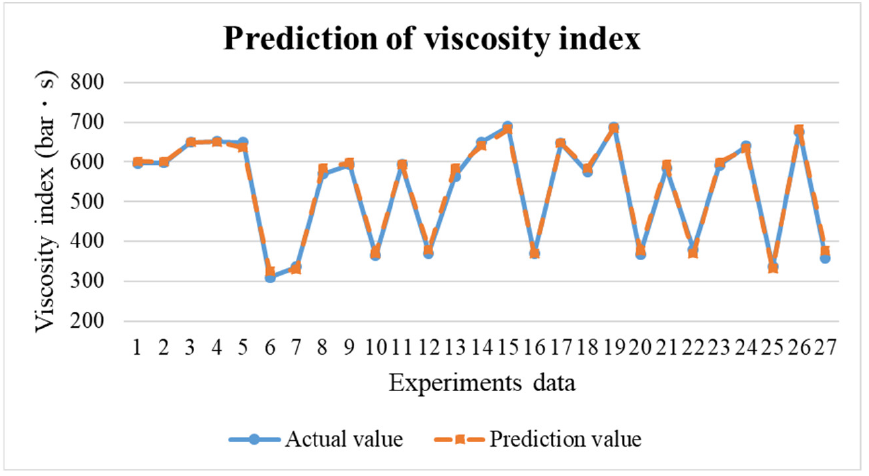
Figure 17. Prediction results of viscosity index.